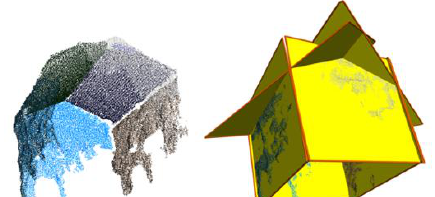
Figure 14. Input point cloud (left) and selected face candidates (right), where no face exists for the bottom of the